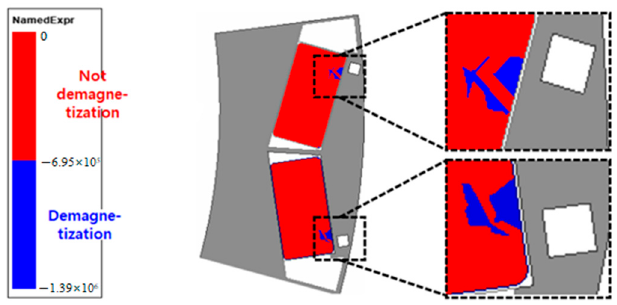
Figure 15. Irreversible demagnetization region with different air hole positions towards an air gap: